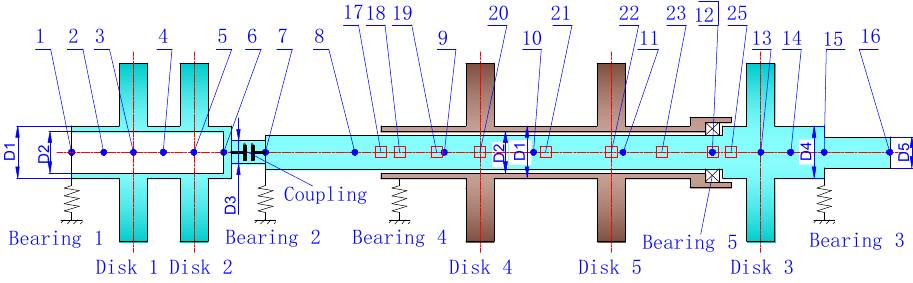
Figure 1. Structure diagram of a dual-rotor system with five supports. Table 1. Bearing properties of the rotor